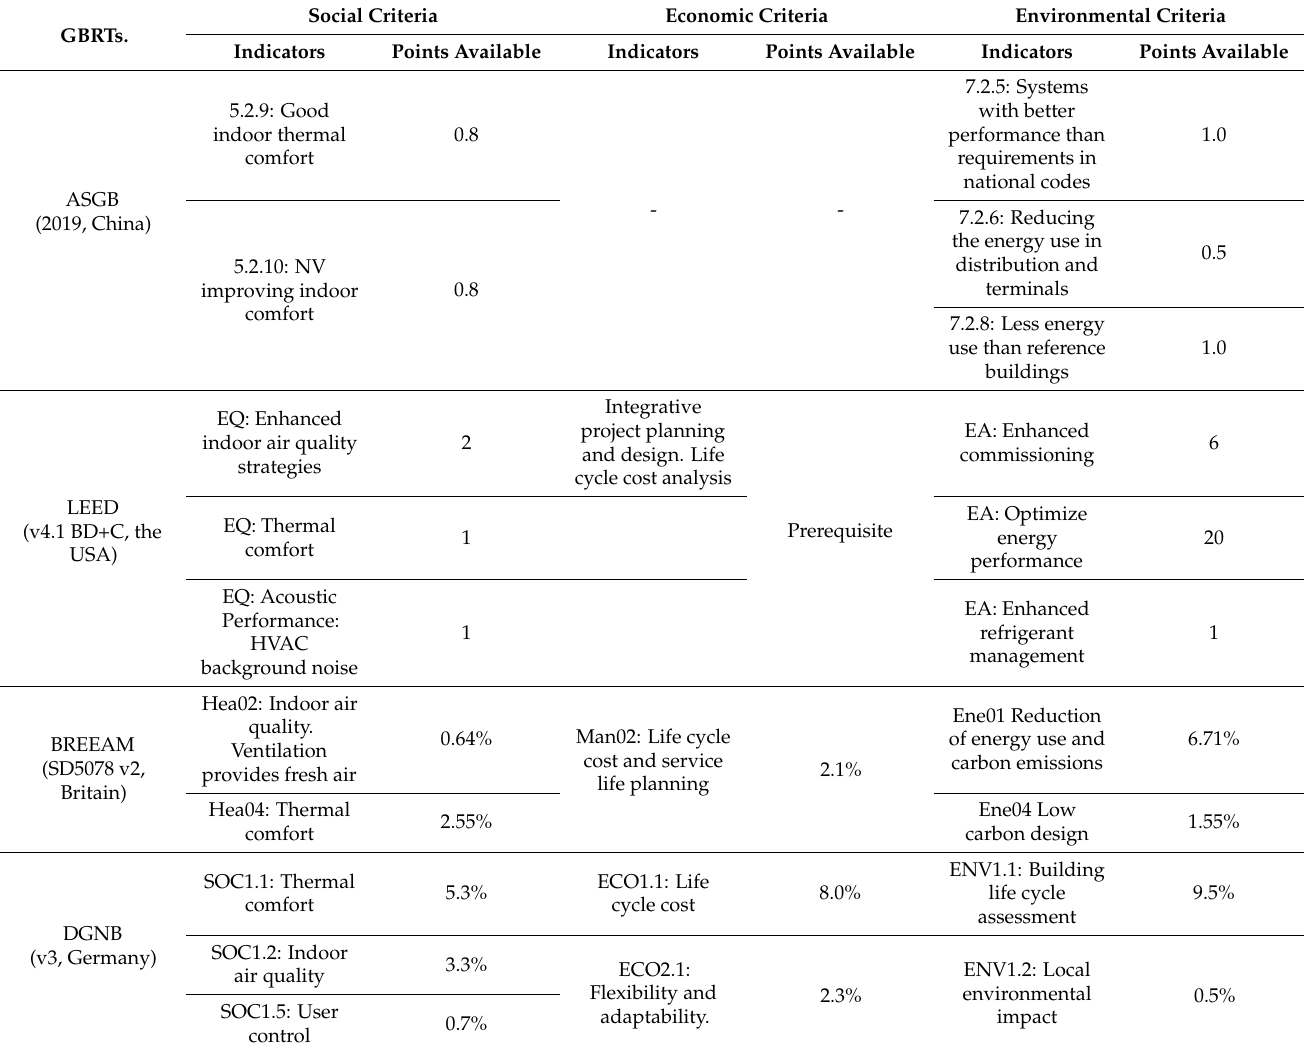
Table 3. HVAC-related indicators in GBRTs of the four